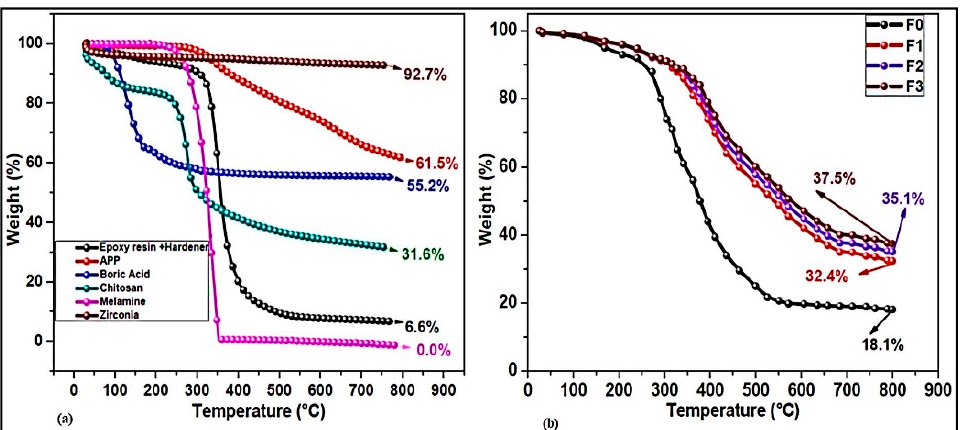
Figure 11. Thermal gravimetric analysis (TGA) graph of the ( a ) individual components and ( b ) flame retardant samples.